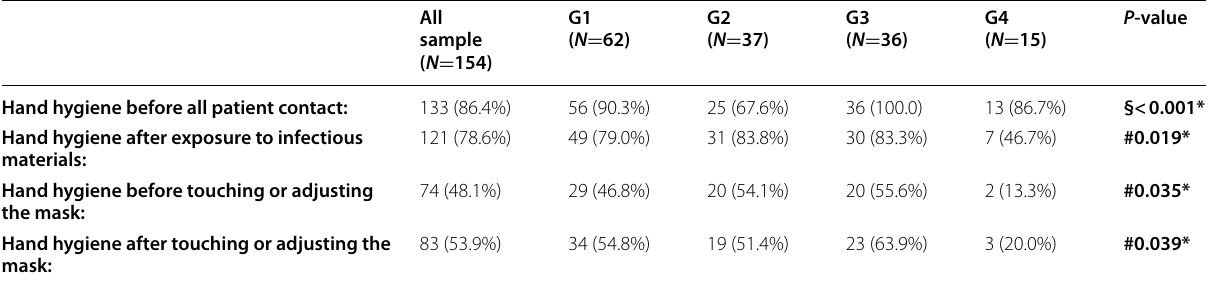
G1 (Western European), G2 (Middle Eastern), G3 (Latin American), G4 (Eastern European) countries’ participants # Chi-square test. §Fisher’s Exact test. *Significant